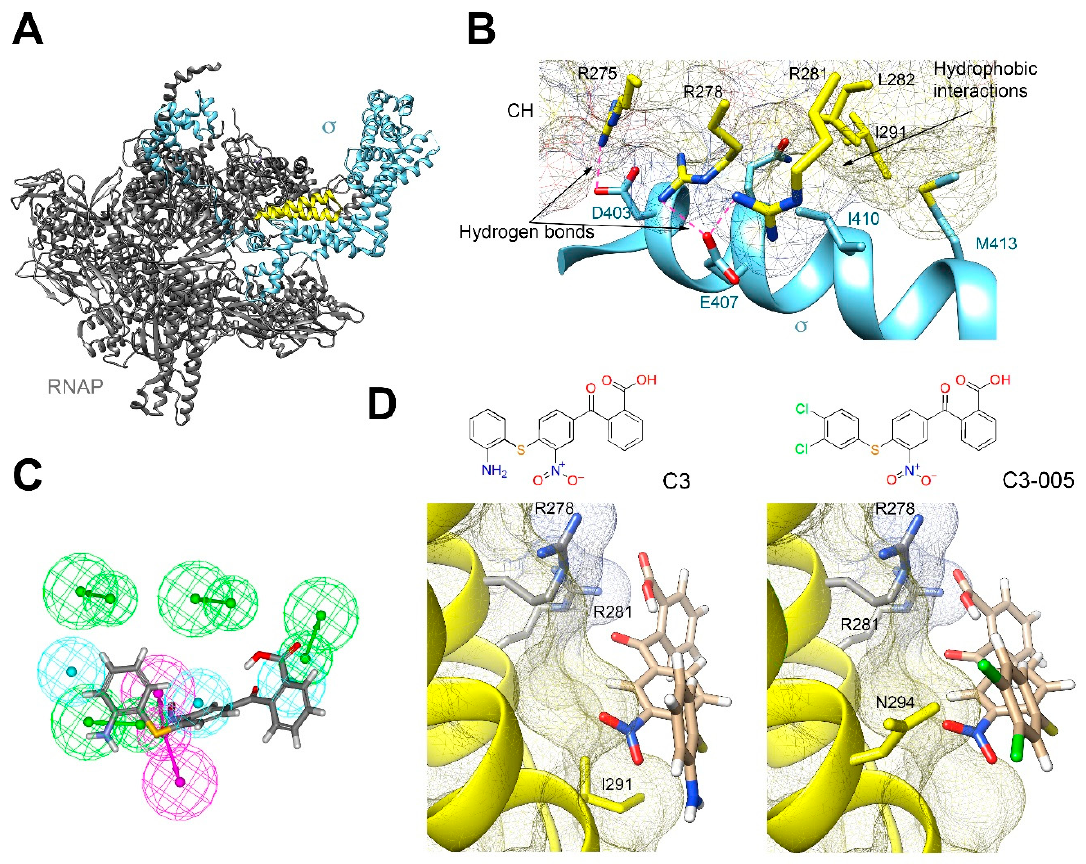
Figure 1. Inhibitors of RNAP- σ interaction. ( A ) The crystal structure of E. coli RNAP holoenzyme (PDB: 4LJZ; 27) with the RNA polymerase core enzyme colored in gray, the CH region in yellow and σ 70 in blue. ( B ) The interaction between RNAP CH region (surface in mesh) and the N-terminal domain of σ 70 (blue helix) with key amino acid residues labeled. ( C ) C3 docked in the pharmacophore model. Green spheres, H-bond acceptors; pink spheres, H-bond donor; cyan spheres, hydrophobic groups. ( D ) The docking model C3 (left) and C3-005 (right) with the CH region in yellow helix and mesh surface.